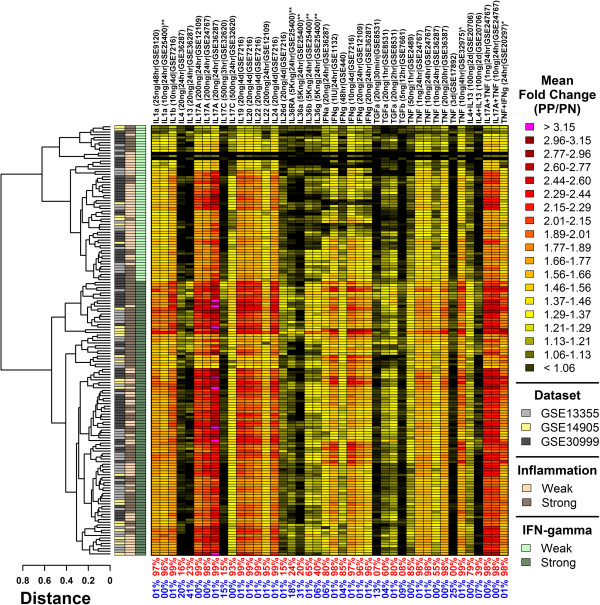
Psoriasis lesions from 163 patients can be divided into two subgroups based upon the expression of cytokine-induced genes (IFN-γ-strong: 104/163; IFN-γ-weak: 59/163). Signature scores were calculated for each patient based upon the 250 genes most strongly induced in each of 42 cytokine experiments (top margin). Signature scores were calculated as the weighted average of fold-changes (PP/PN) among the 250 most strongly induced genes (weighted arithmetic mean). The greatest weight was assigned to the top-ranked gene, with weights declining between the top-ranked and 250th-ranked gene. Values in the bottom margin indicate the proportion of patients for which signature scores were significantly large (red) or small (blue). Significance was evaluated by comparing fold-changes (PP/PN) of the 250 signature genes to those of all other genes represented on the array (Wilcoxon rank sum test). Patients were clustered according to signature scores using complete linkage and the Euclidean distance metric. Group assignments were made based upon whether a patient’s scores approximated a strong or weak pattern of IFN-γ activity (see legend).